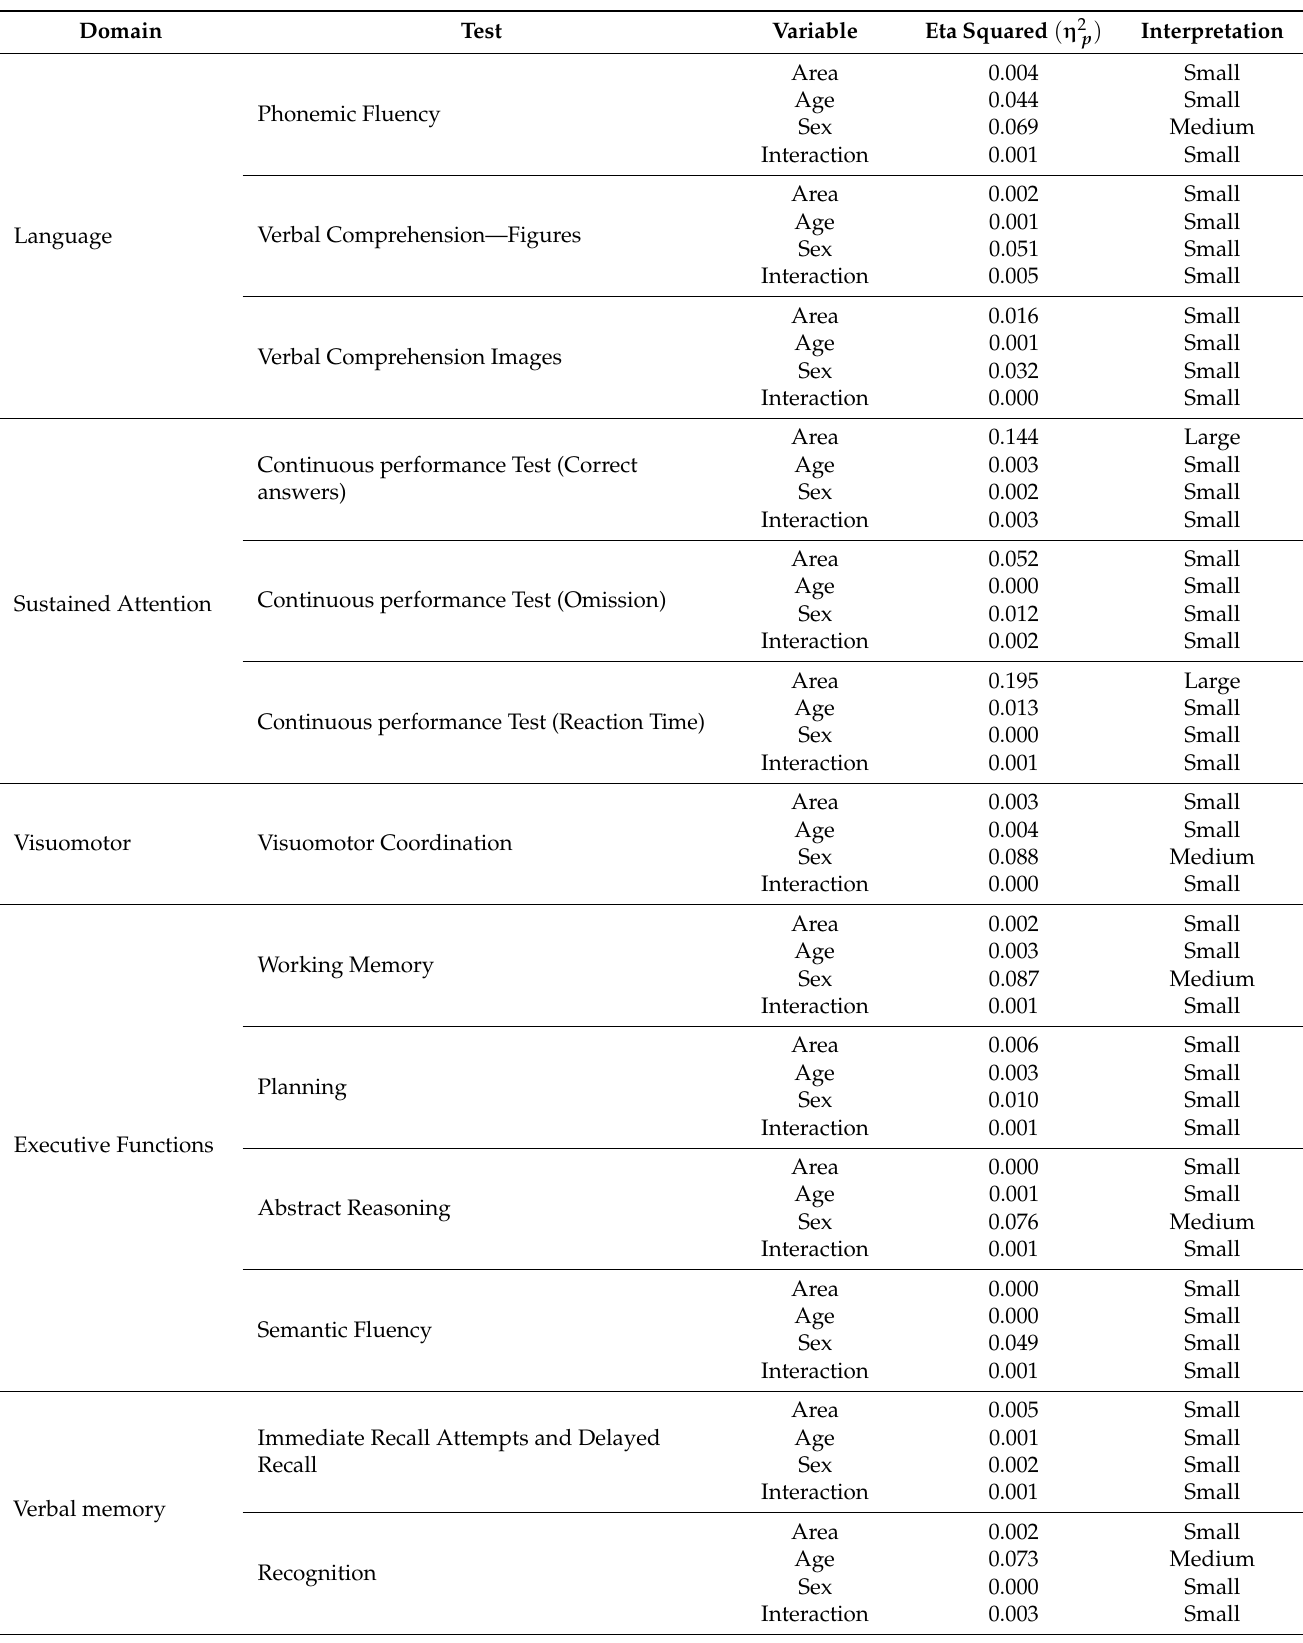
Table 5. Effect size and